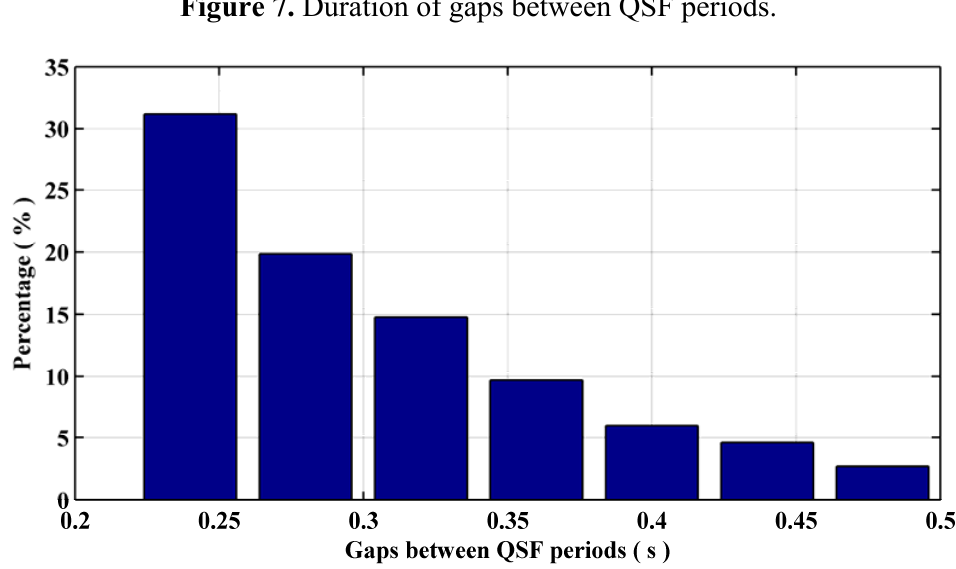
Figure 7. Duration of gaps between QSF